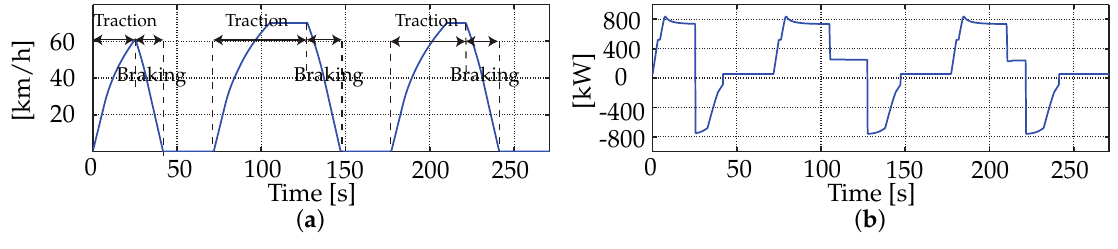
Figure 3. 3 Typical stops in the driving cycle of the Light Rail (LR): ( a ) speed and ( b ) power demand